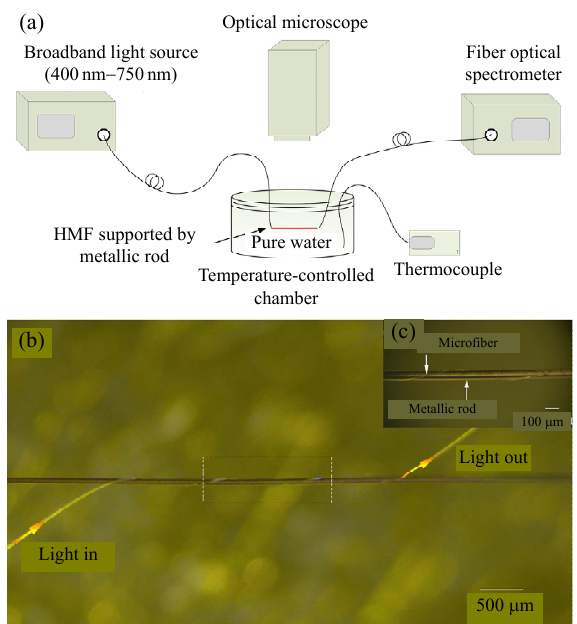
Fig. 3 Experimental setup of HMF temperature sensing system: (a) illustration of the experimental setup of the temperature measurement based on HMF sensor, (b) typical optical micro image of the HMF, and (c) the enlarged image of the rectangle part